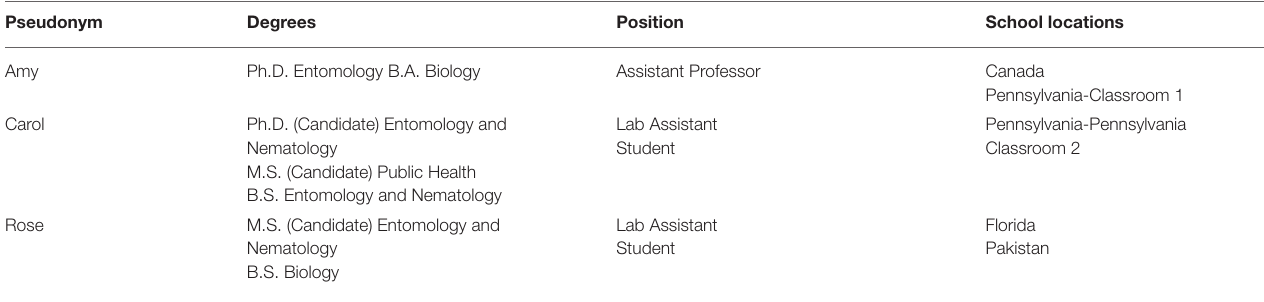
TABLE 1 | Scientist pseudonyms, degrees, positions, and locations of Skype schools connected with during their EFTs.